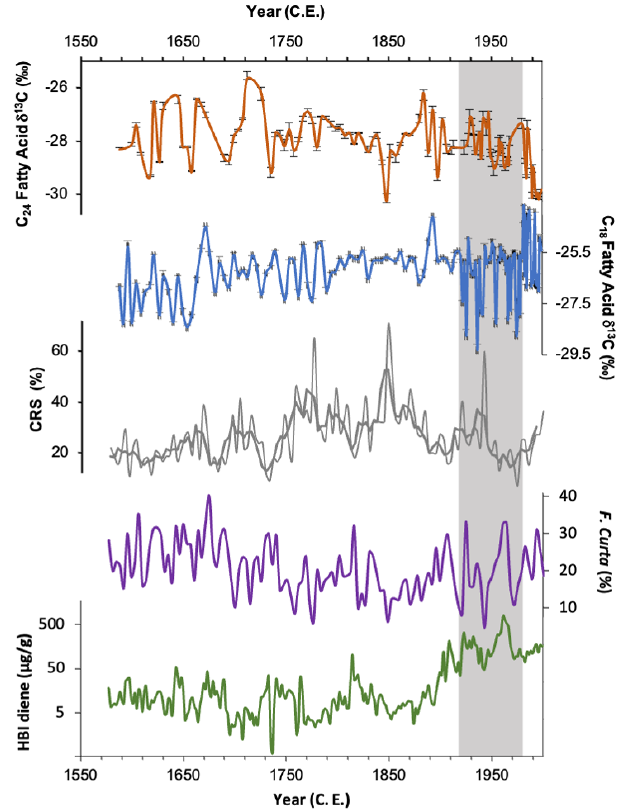
Figure 7. δ 13 C of the C 24 (orange) and C 18 (blue) fatty acid, HBI diene concentrations (green; plotted on a log scale) and relative abundances of Fragilariopsis curta plus Fragilariopsis cylindrus (purple). The latter two records reflect sea-ice concentrations. The grey vertical band highlights the period where low C 18 δ 13 C over- laps with elevated HBI diene